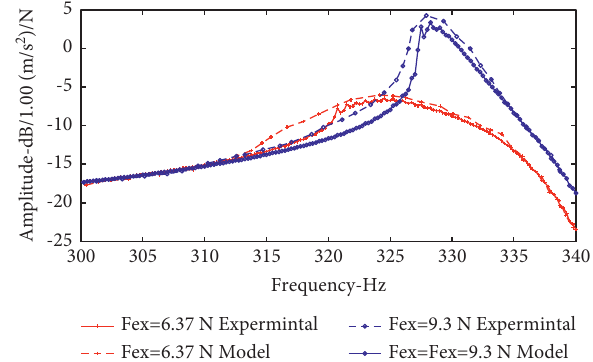
Figure 14: Comparison of the result of experimental test and prediction response of the model with considering coupling effect. Continuous lines are experimental results, and dashed lines are theoretical model.